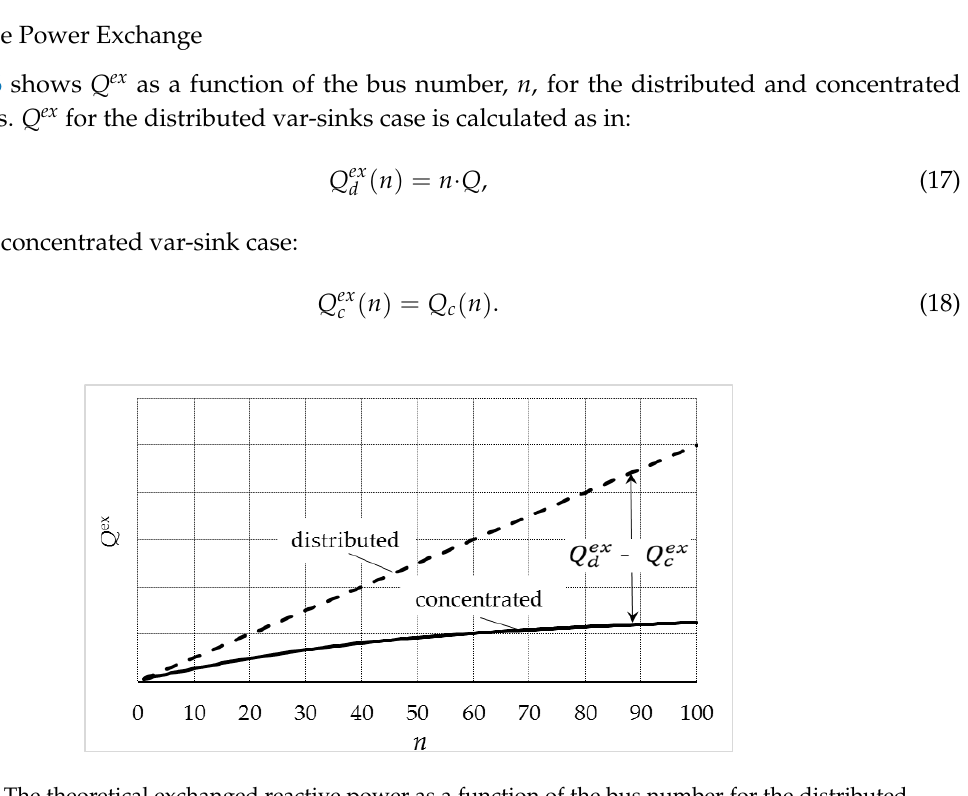
Figure 7. The theoretical voltage drop amplitude in every feeder segment as a function of the bus number for the distributed and concentrated var-sink cases. 2.5.3. Voltage Profile Figure 8 shows the theoretical voltage profile for the distributed and concentrated var-sink cases. Although the voltages at fhb and feb are equal in both cases, the voltage values in the distributed case are lower than in the concentrated one, especially in the middle of the feeder. In the case of distributed var-sinks, the voltage profile behaves convexly, while in the concentrated var-sink case, it shapes linear.